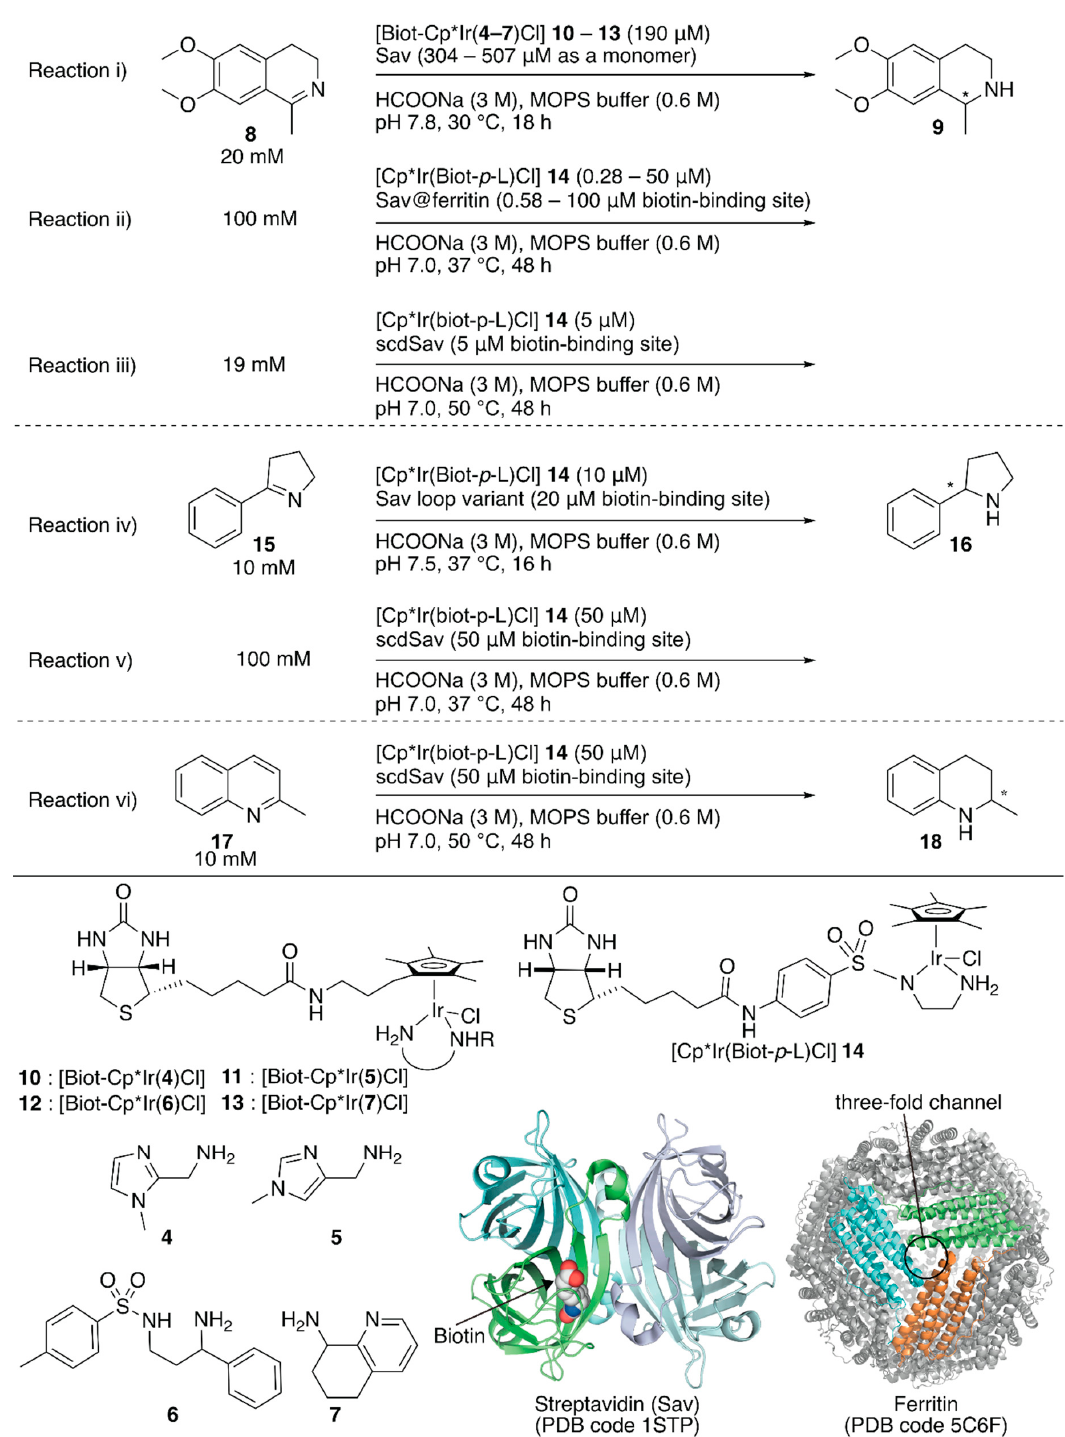
Figure 2. Transfer hydrogenation of imines catalyzed by Sav-based artificial transfer hydrogenases. Adapted from [35–38].